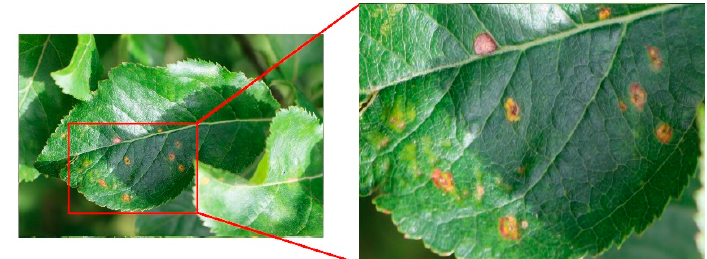
Figure 7. Leaf with apple scab.